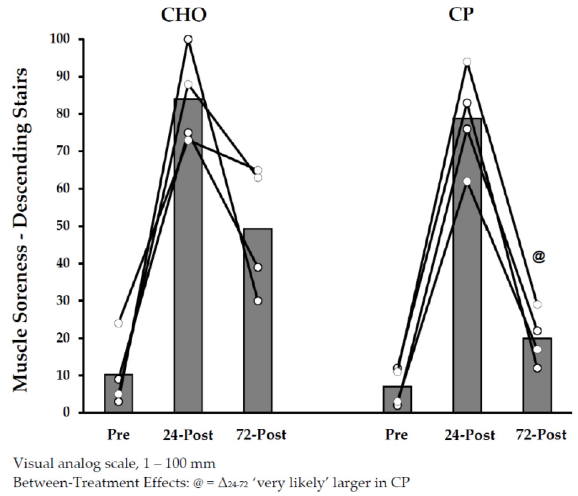
Figure 5. Muscle Soreness Ratings (Descending Stairs) with Protein Supplementation Post ‐ Exercise.